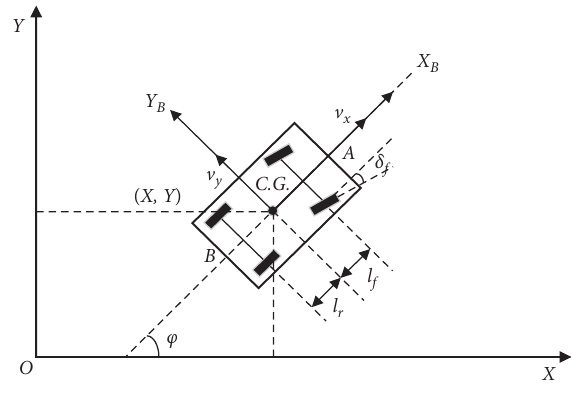
Figure 8: 3-DoF vehicle